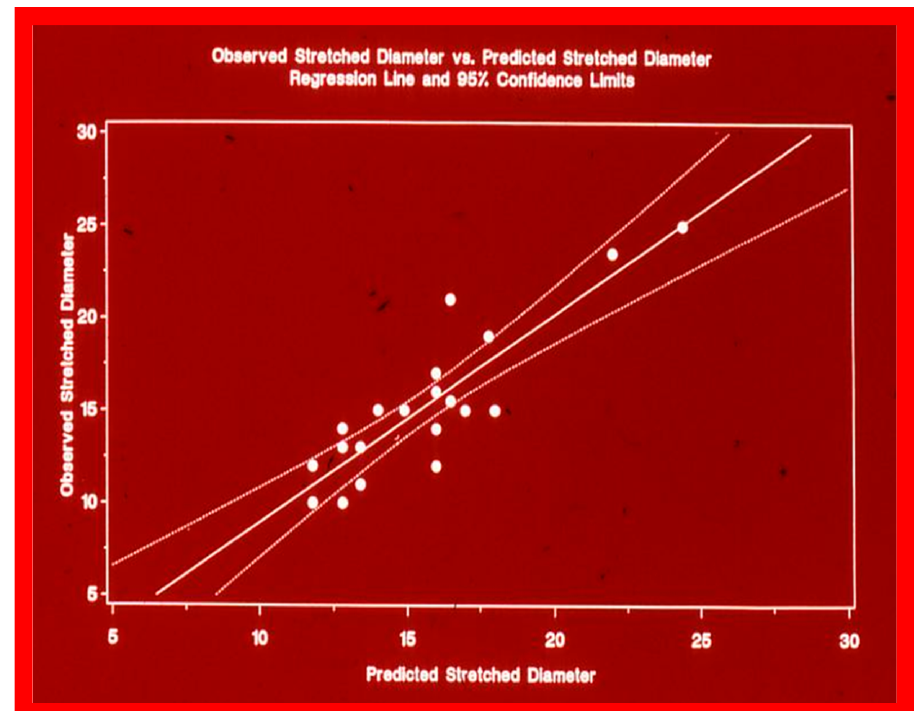
Figure 22. Plot is drawn demonstrating the correlation of the calculated diameter of the atrial septal defect (ASD) by the equation ([1.05 × echo diameter in mm] + 5.49) with the balloon-sized ASD diameter. Statistically important ( p < 0.001) relationship with an r value of 0.9 was found. Modified from Reference [47].